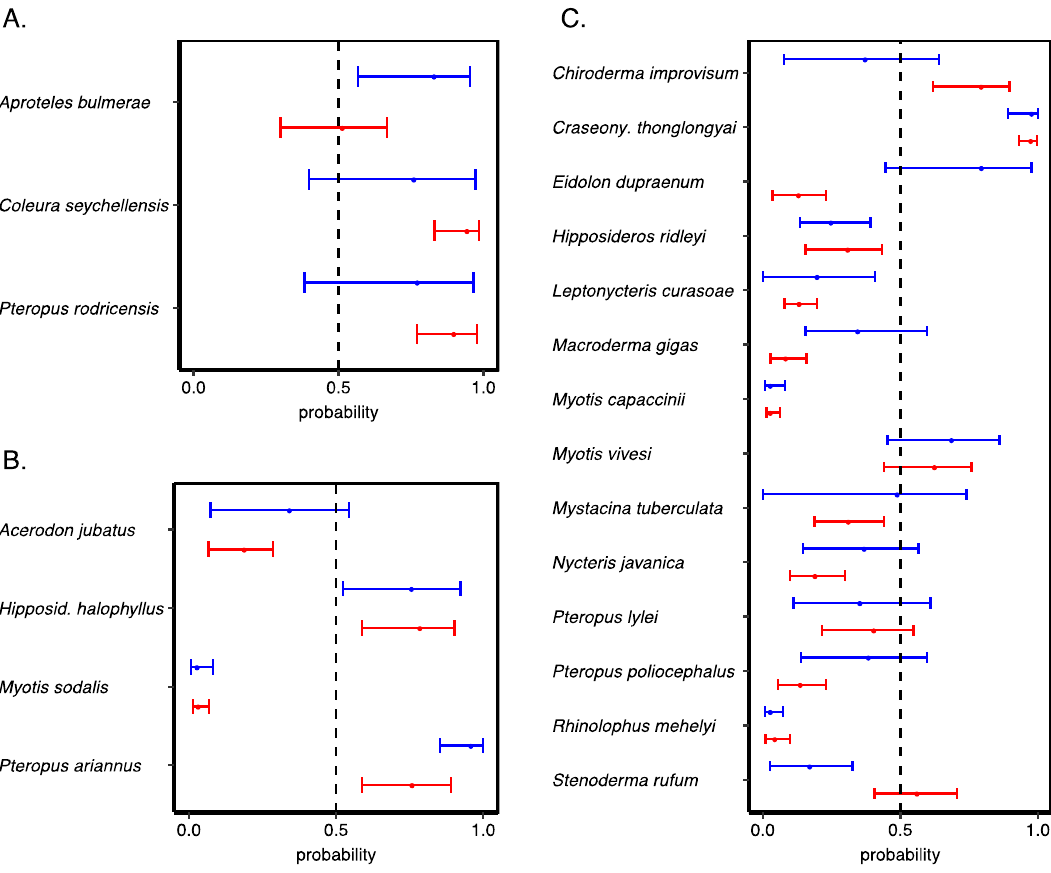
Figure 2. Comparison of 95% prediction intervals given extinction risk estimates of the predictor-rich (blue) and taxon-rich (red) model simulations. The prediction interval is based on summarizing 1000 simulations of extinction risk using our phylogenetic logistic regression model. A species was considered threatened if its median proportion of times it simulated to have high risk was greater than or equal to 0.50. Prediction intervals that overlap 0.5, demonstrate uncertainty of threat status given the model. IUCN Red List designations as follows: ( A ) Critically Endangered (CR), ( B ) Endangered (EN), ( C ). Vulnerable (VU).